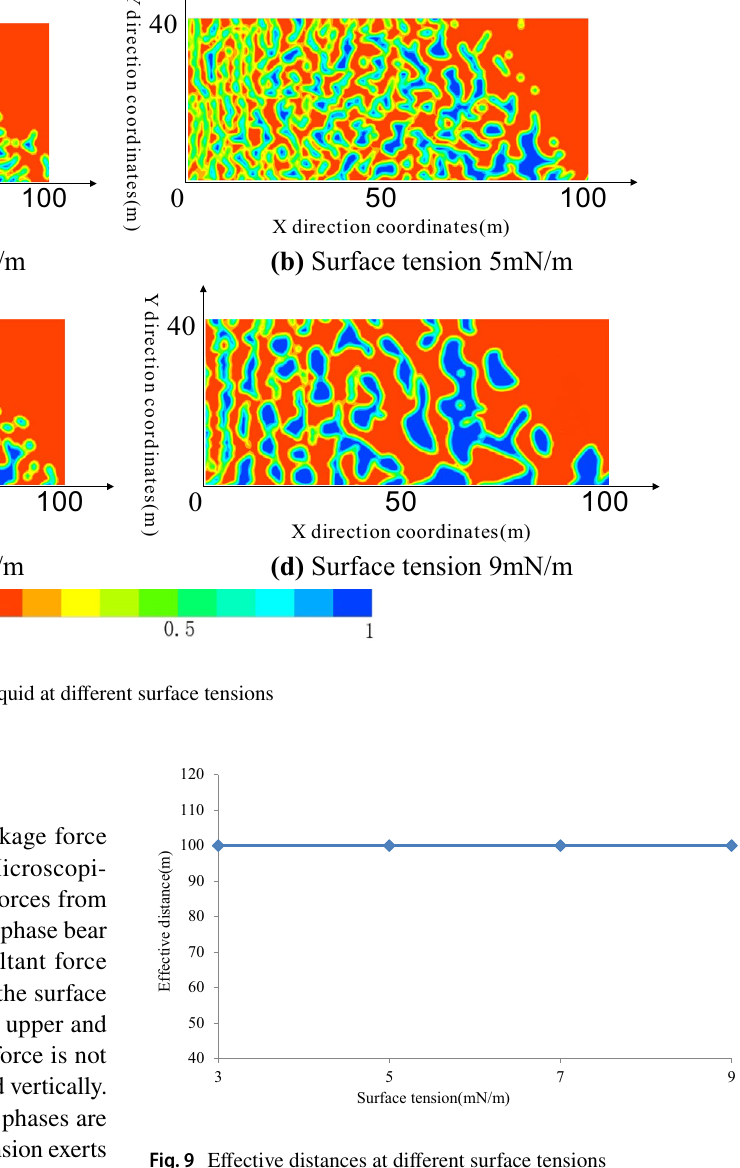
Fig. 9 Effective distances at different surface tensions